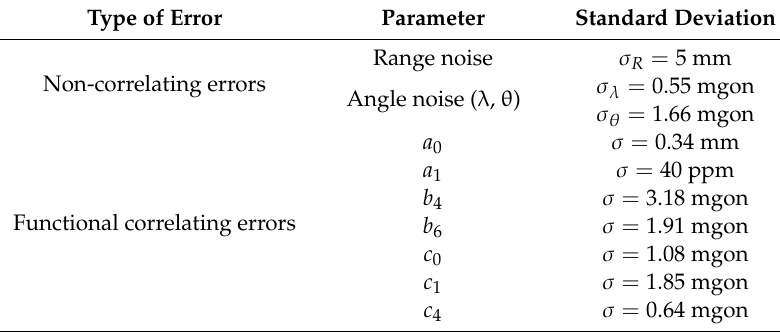
Table 1. Classification of instrumental errors and their